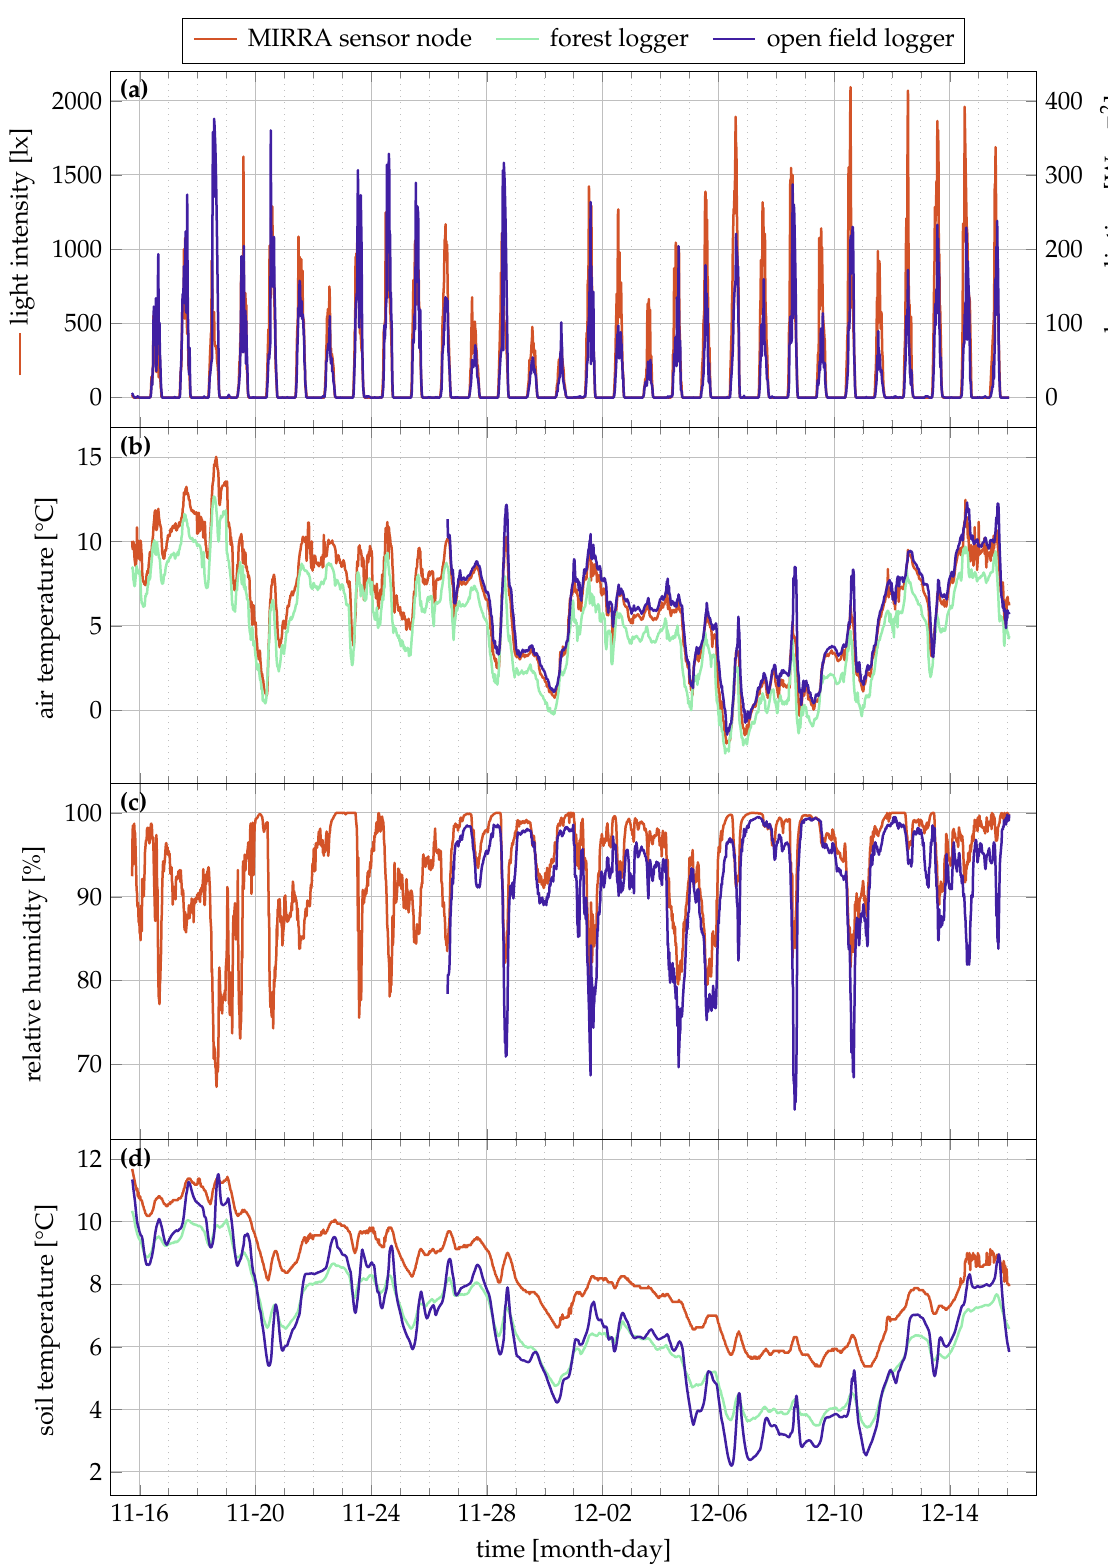
Figure 4. Measurement data of the MIRRA sensor during the month-long trial in 2020 and reference locations. Each of the subfigures details a separate quantity: ( a ) Light intensity in lx (left axis) and Wm − 2 (right axis); ( b ) air tempera- ture; ( c ) relative humidity and ( d ) soil moisture. For the open field logger, there is no data for some quantities